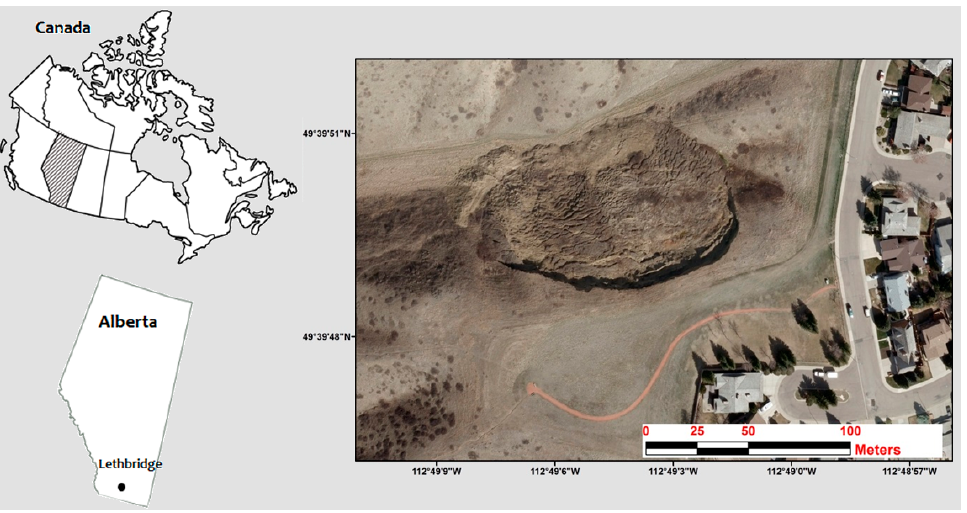
Figure 1. Geographic location of study area (southern part of Lethbridge, Alberta Canada).